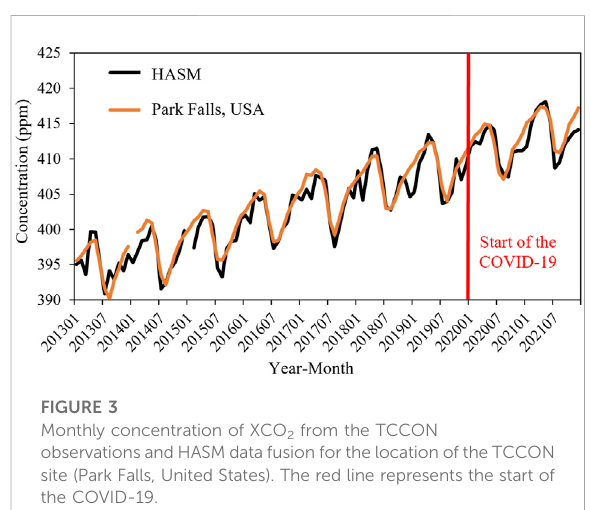
Monthly concentration of XCO 2 from the TCCON observations and HASM data fusion for the location of the TCCON site (Park Falls, United States). The red line represents the start of the